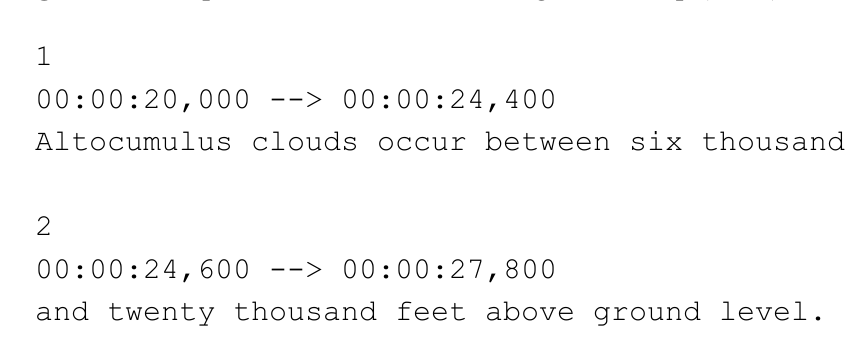
Figure 1. Example of subtitles defined using the SubRip (.SRT)